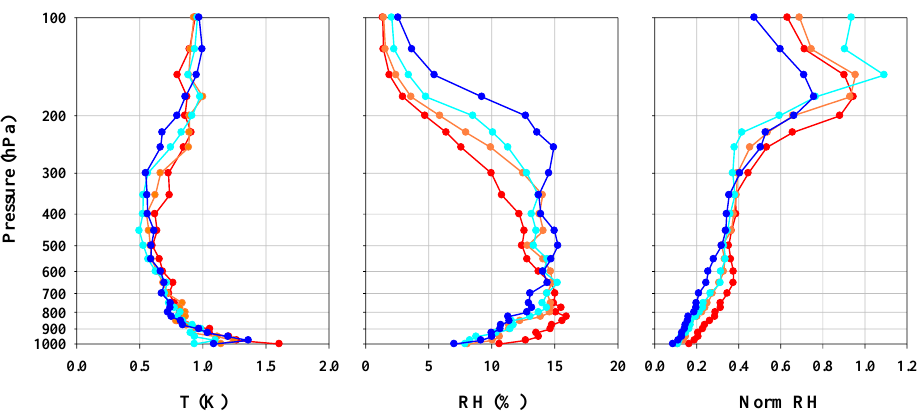
Figure 8. Error statistics of the European Centre for Medium-Range Weather Forecasts Interim reanalysis (ERA-Interim) temperature and relative humidity profiles classified according to the total precipitable water between the surface and 100 hPa (TPW, in kg·m −2 ). ( a ) Bias and ( b ) RMSD.